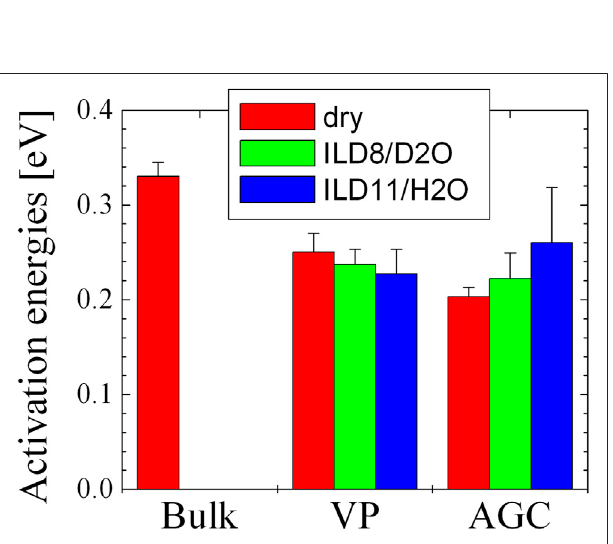
FIGURE 8 | The conductivity of bulk EmimAc with molar equivalents of water.Withinerrors(ofsymbolsize),theconductivityincreasesmonotonically.